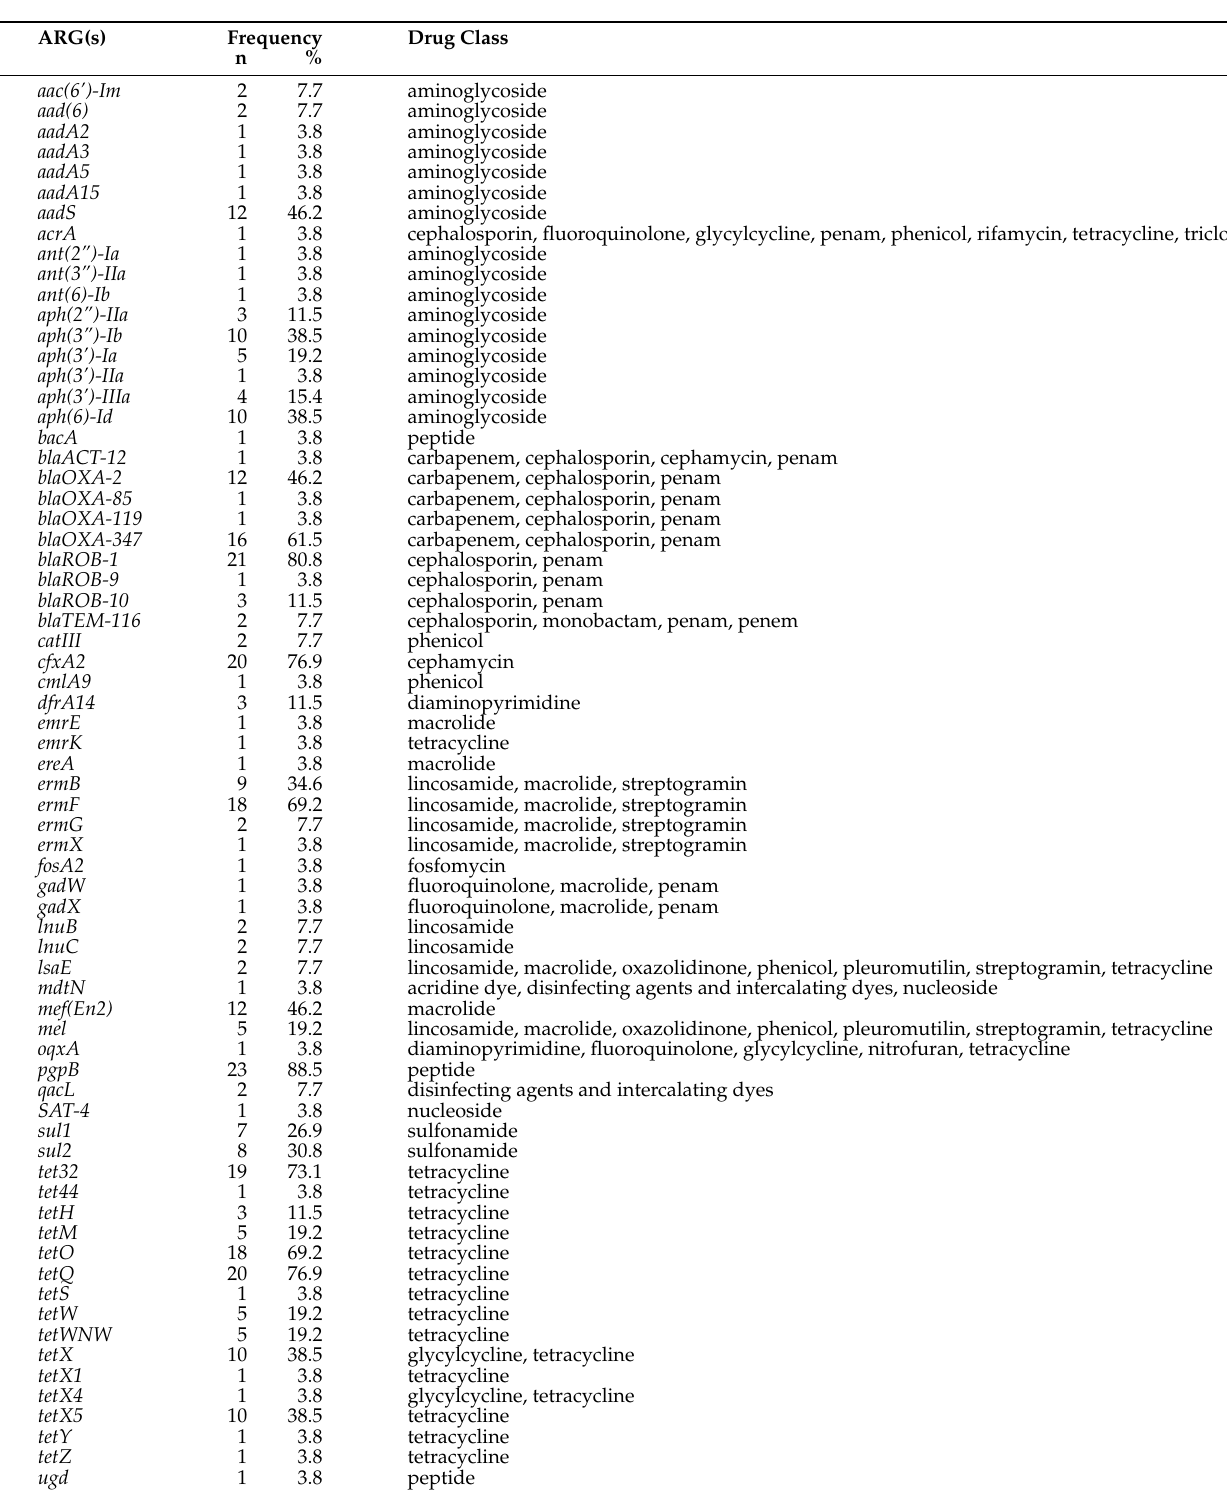
Table 2. Identified ARGs and the drug classes affected by them. The frequency columns show how many samples the genes occurred